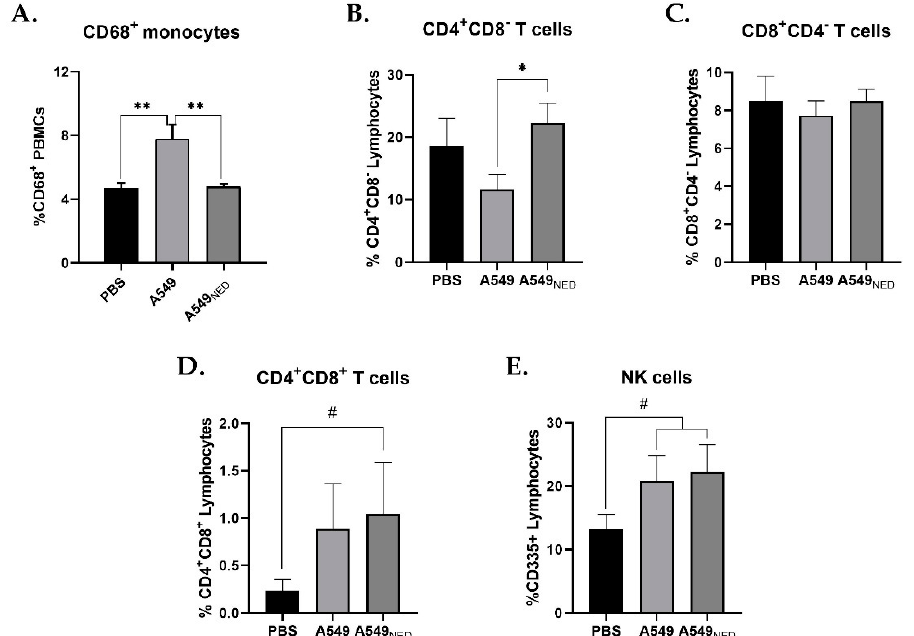
Figure 3. Changes in PBMC profiles after immunization. Flow cytometric analysis of PBMC samples obtained from the different groups of mice, targeting CD68 (a monocyte/macrophage cellular marker), CD4 (a co-receptor for the T cell receptor and specific marker of T helper cells), CD8a (a co-receptor for the T cell receptor and specific marker of cytotoxic T cells), and CD335 (a cytotoxicity-activating receptor that mediates tumor cell lysis and distinguishes NK cells from other populations). The bar graphs show the percentage of CD68 + ( A ), CD4 + ( B ), CD8 + ( C ), double positive CD4 + /CD8 + ( D ), and CD335 + ( E ) cells in PBMCs from the different groups of mice. Results are presented as the mean ± SEM (n = 4, ** p < 0.01, * p < 0.05, # p < 0.1).